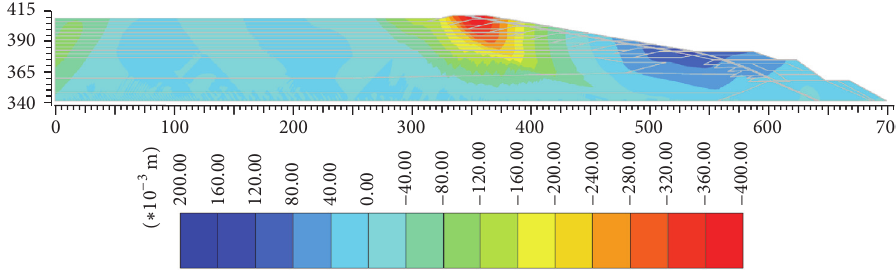
Figure 18: Vertical displacements in the dam after shaking with extreme earthquake. The positive direction is upward.